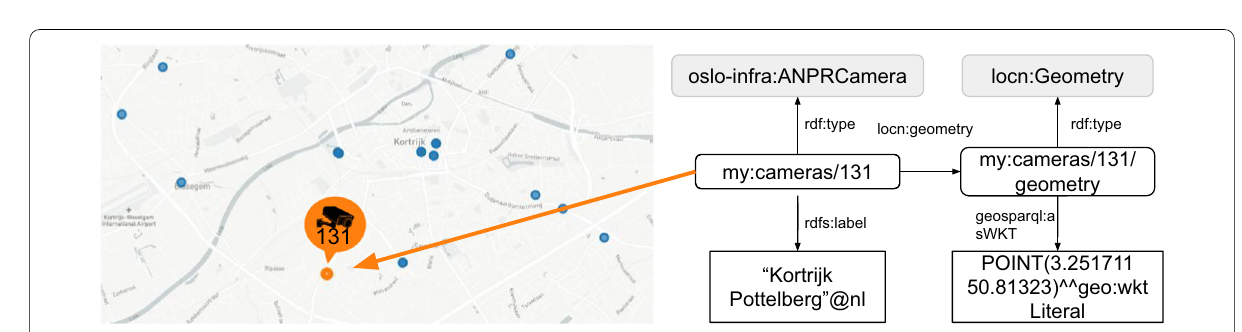
Fig. 5 Overview of cameras in Kortrijk with camera 131